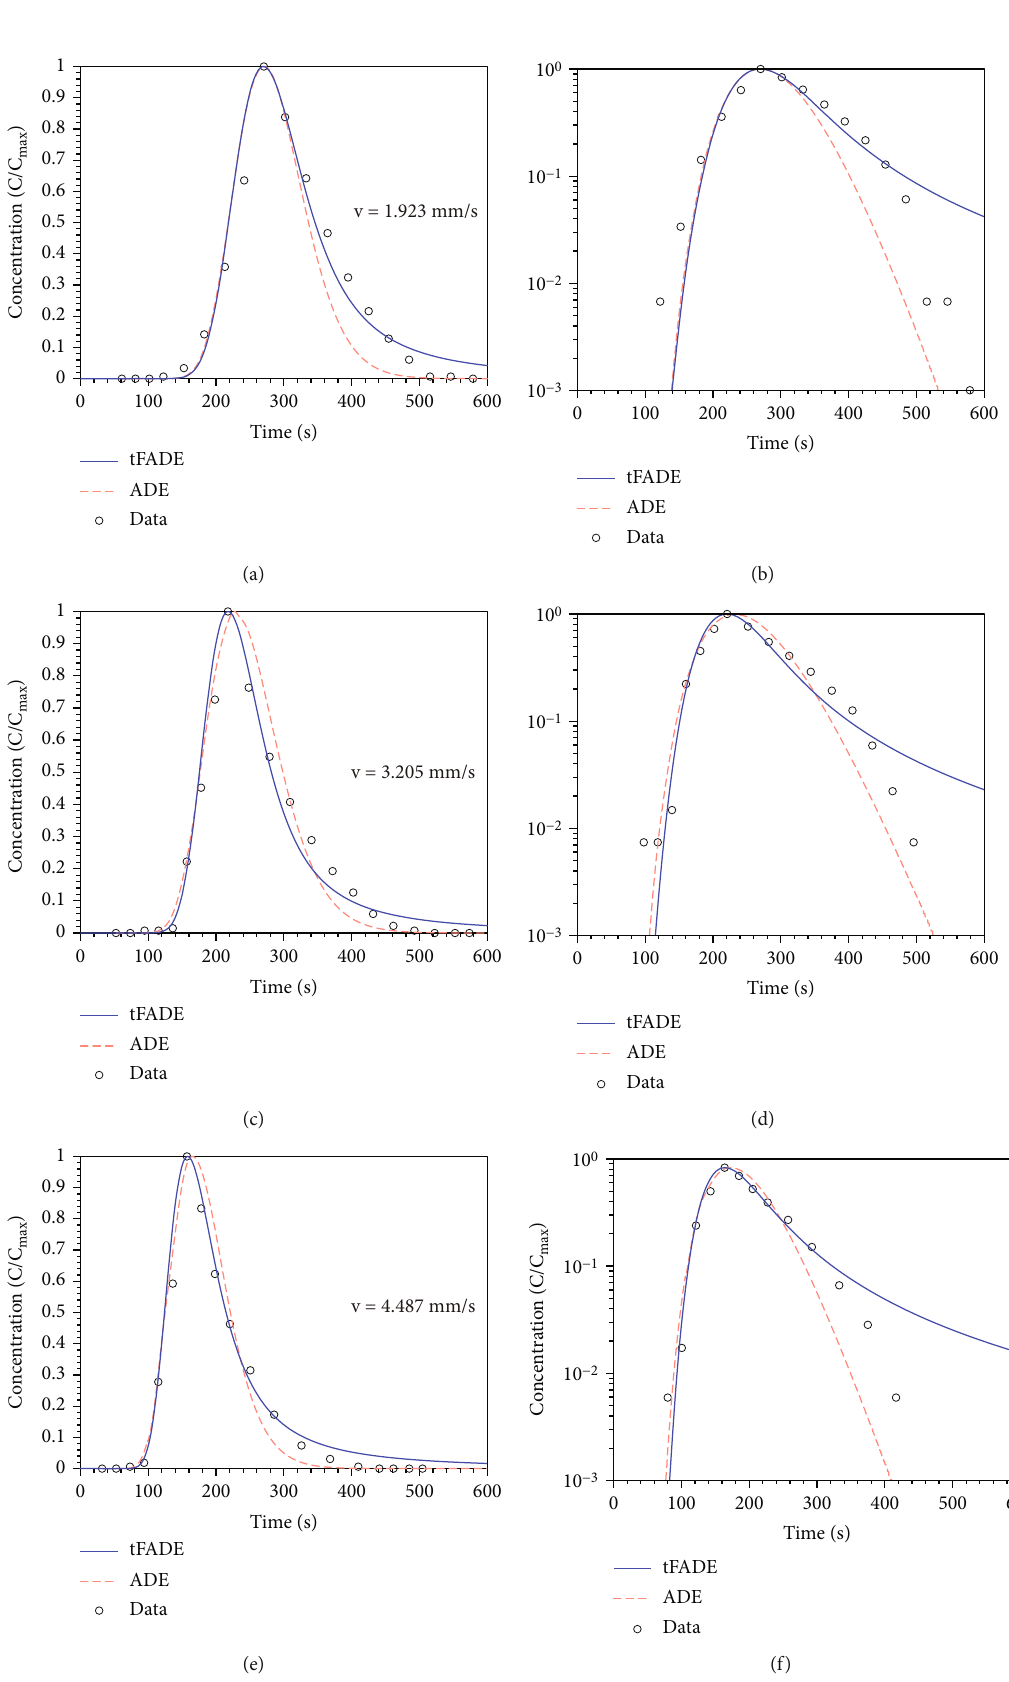
Figure 5: Fitting BTCs for the BBF transport using tFADE and ADE in the granite fracture with fl ow